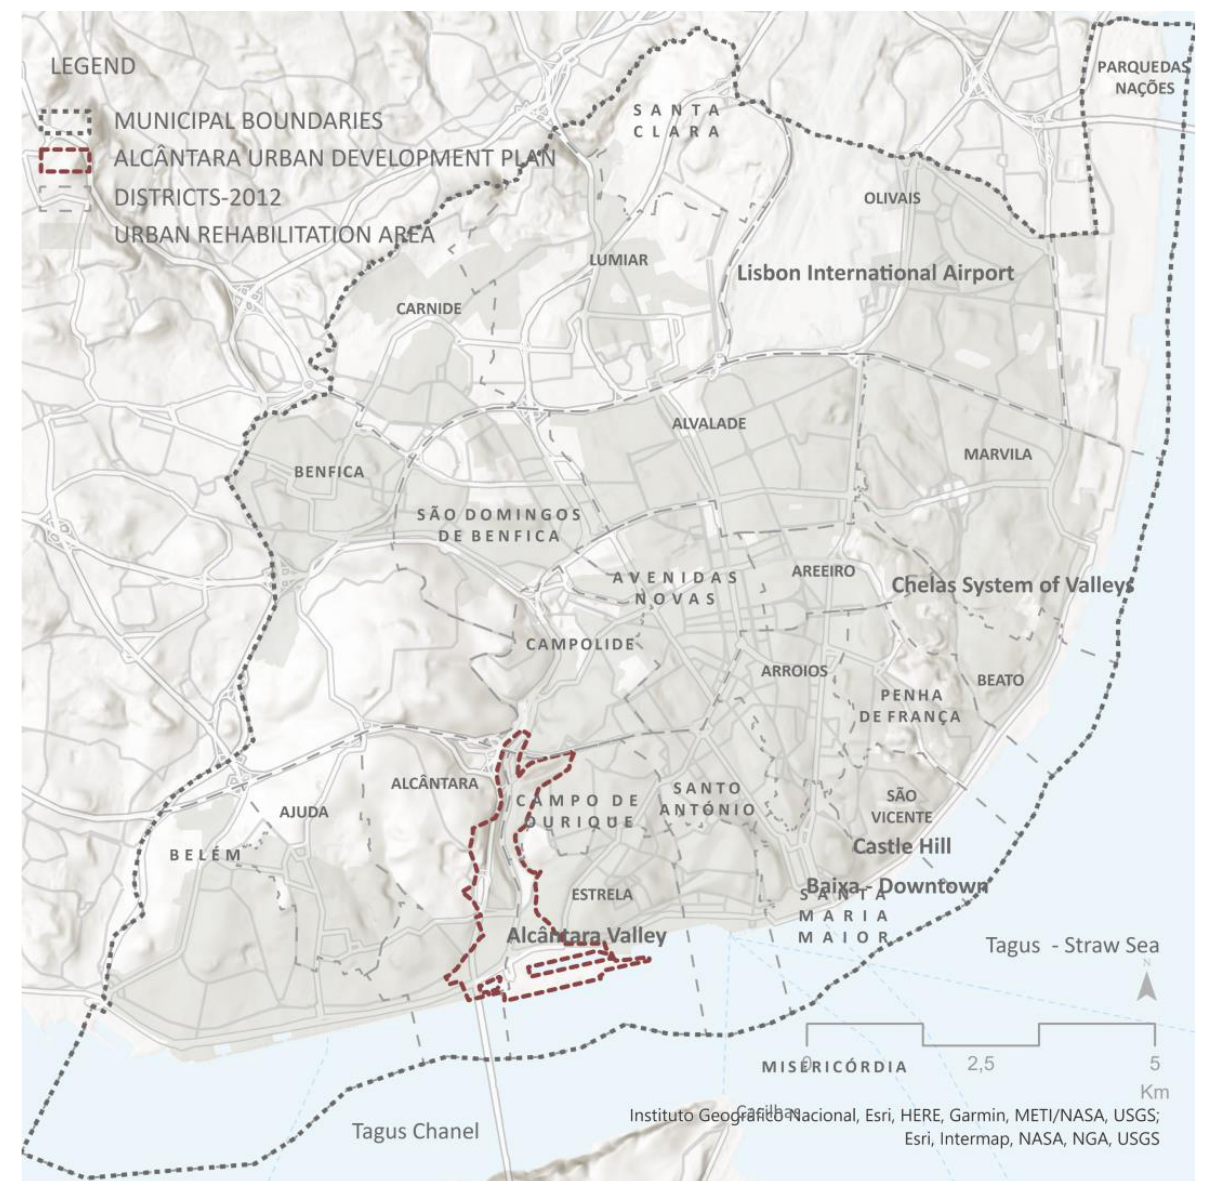
Figure 1. The Municipality of Lisbon, municipal and district boundaries, Urban Rehabilitation Area, Development Plan for Alcântara. Sources: Own production adapted from CML open-source databases (see Backmatter).